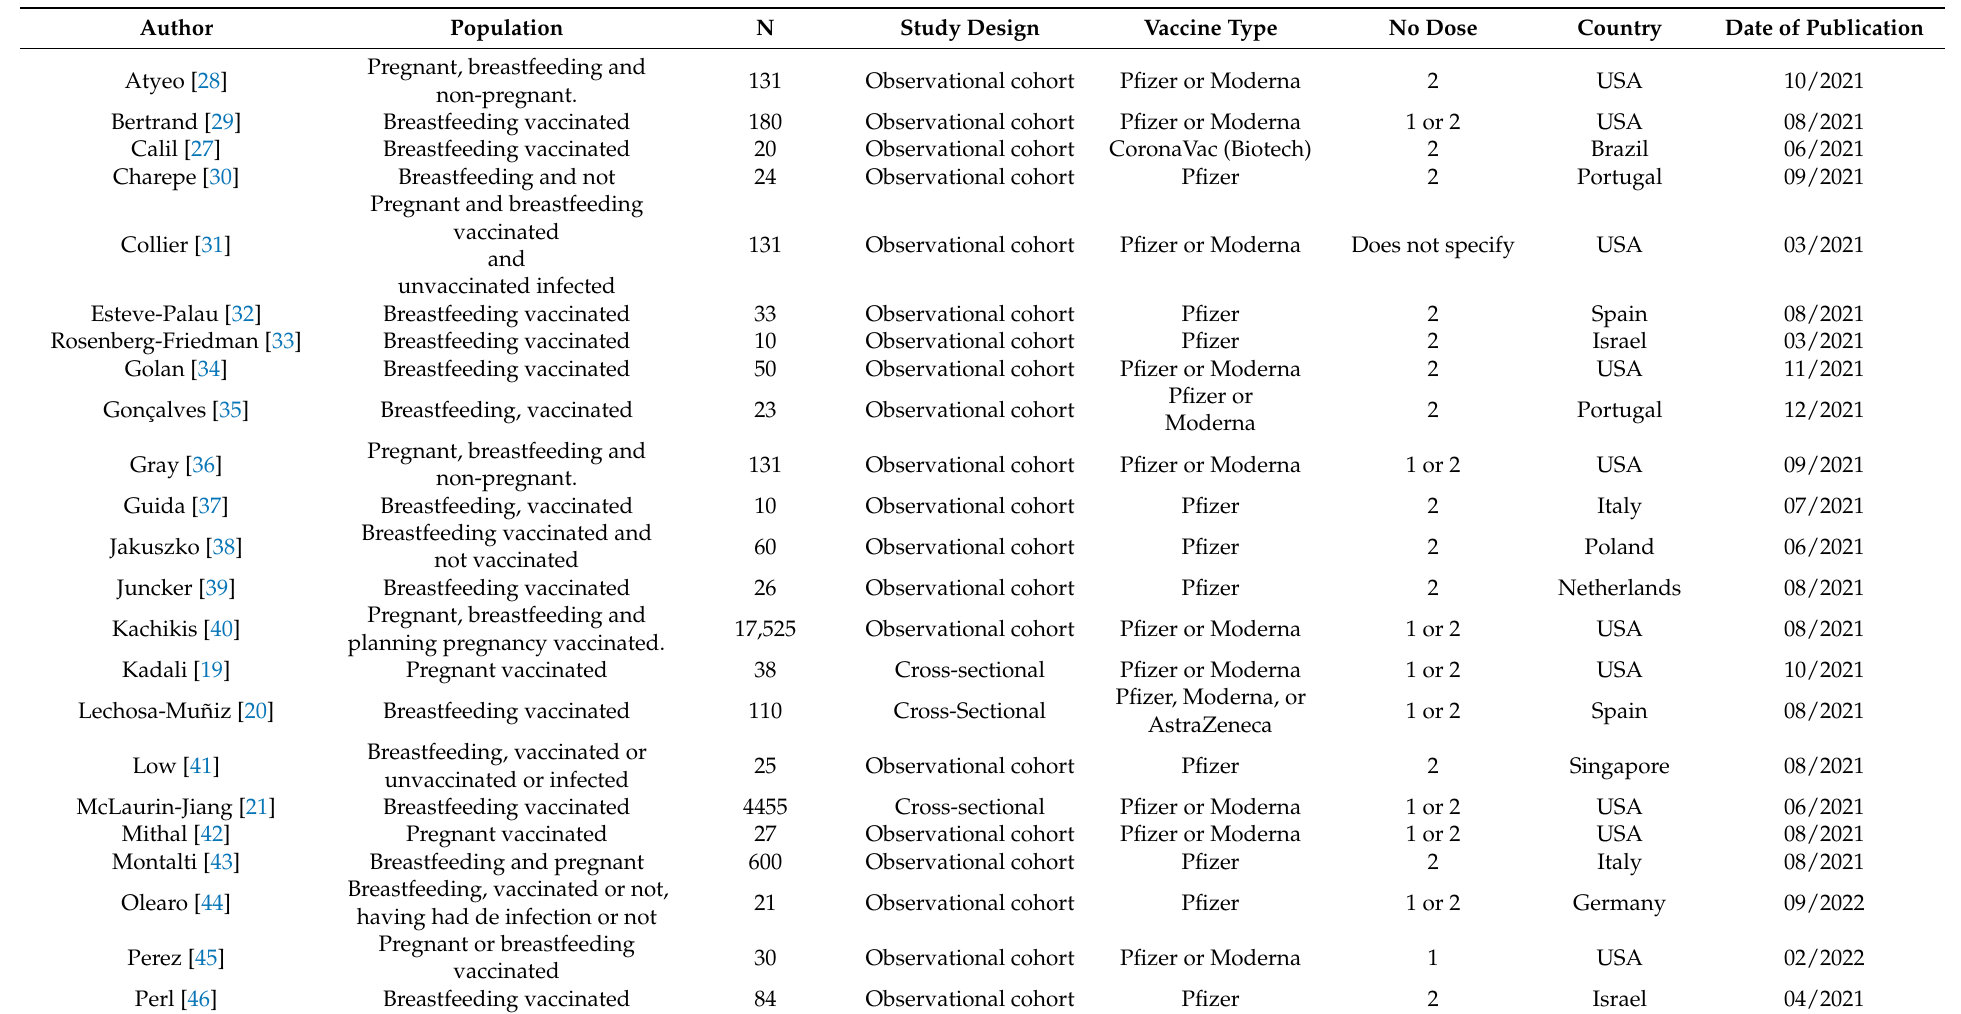
Table 1. Characteristics of the studies included in the systematic